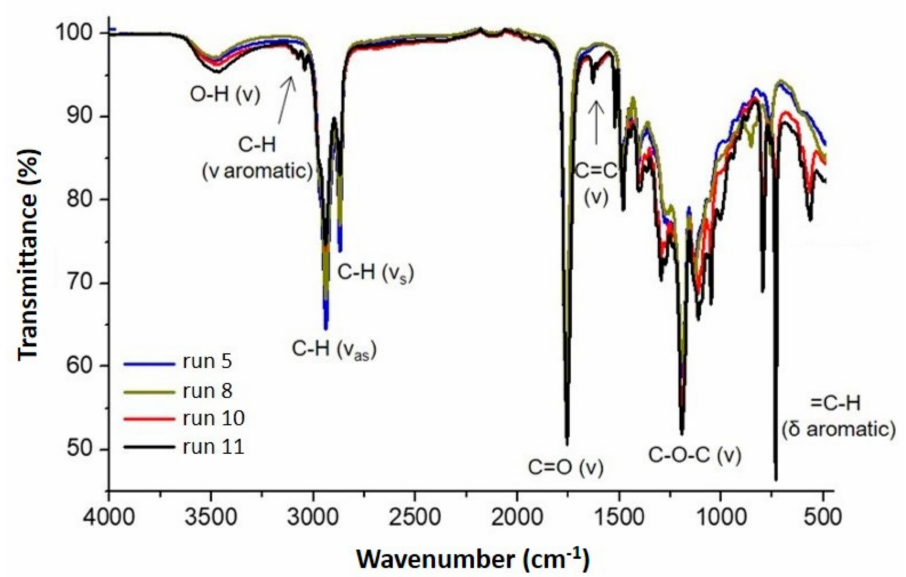
Figure 5. FTIR spectra of the selected bio-polyols from CA (caprylic acid; run 5, 8) and 3PBA (3-phenyl butyric acid; run 10, 11).